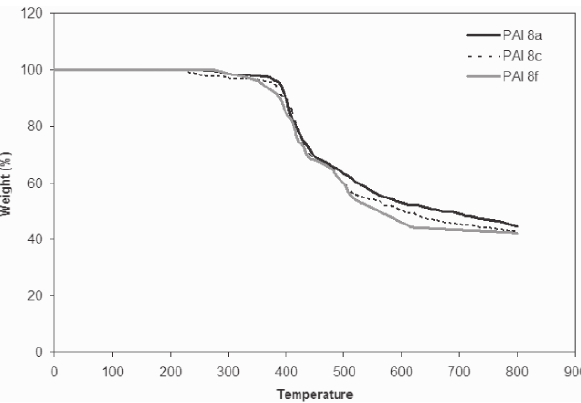
Fig. 6: TGA curves of PAIs 8a , 8c and